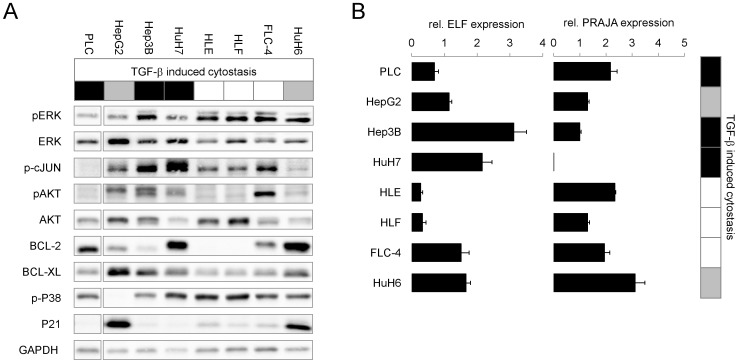
Endogenous expression of survival factors and Smad3 signaling modulators PRAJA and ELF in HCC cells.HCC cell lines were cultured in starvation medium for 24 h. (A) Western blot analysis was performed to evaluate expression levels of Akt, Bcl-2, Bcl-XL, p21 and GAPDH as loading control. Additionally, phosphorylation levels of ERK, c-Jun, Akt (lower band) and p38 were detected. (B) Basal PRAJA and ELF mRNA levels were quantified by Real time PCR analysis using rS18 as reference gene. Tables in (A) and (B) highlight cell lines responding to TGF-β with cell death and growth arrest in black. Cells which mainly show an inhibition of proliferation are marked as grey.